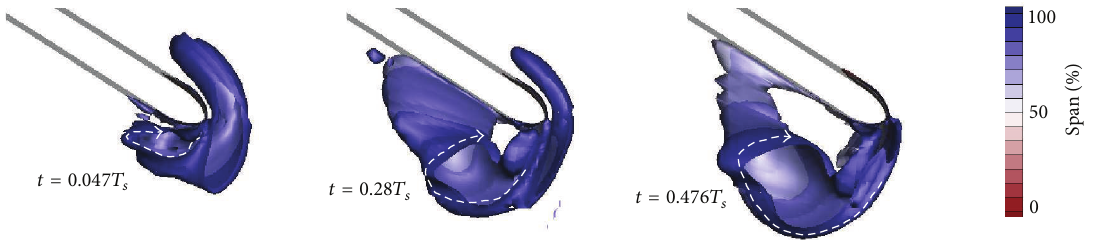
Figure 14: Instantaneous isosurface of the negative 𝜆 2 vortex criterion representing the vortex formation.